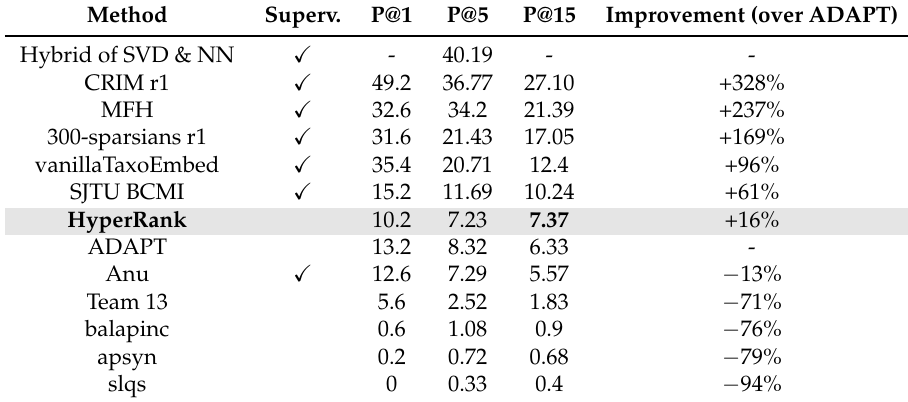
Table 7. Results of evaluation on 2A corpus.